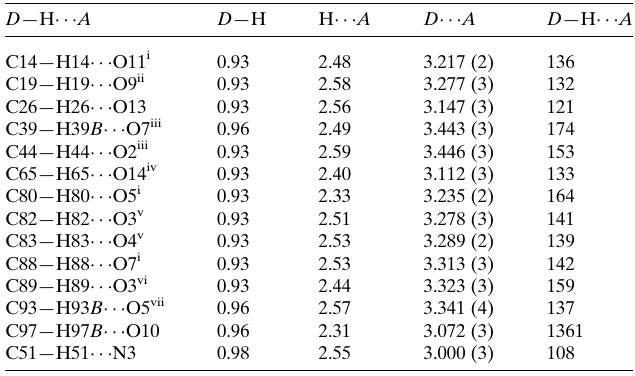
Table 4 Hydrogen-bond geometry (A˚ , (cid:5) ).